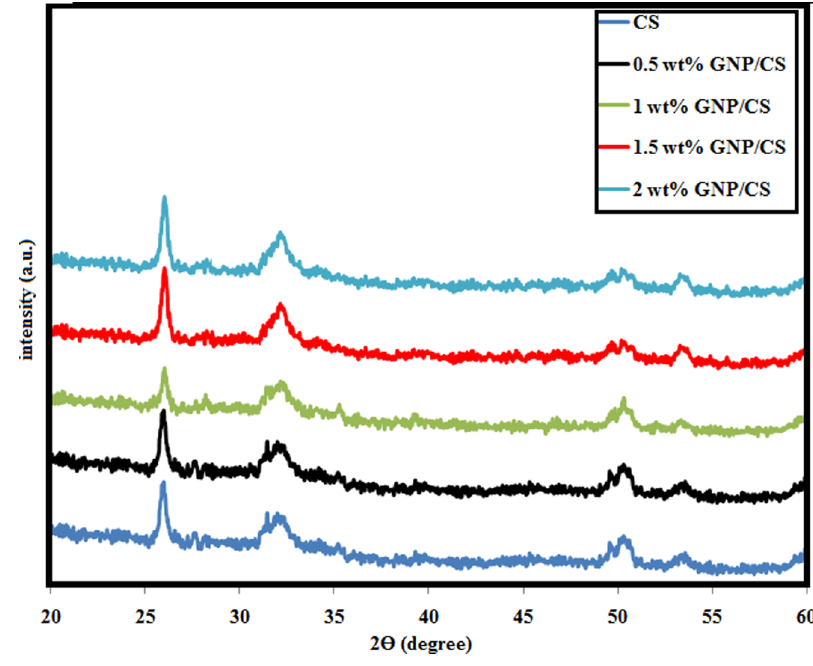
Figure 7. XRD patterns of pure CS and GNP/CS composites after soaking in the SBF solution for 14 days.